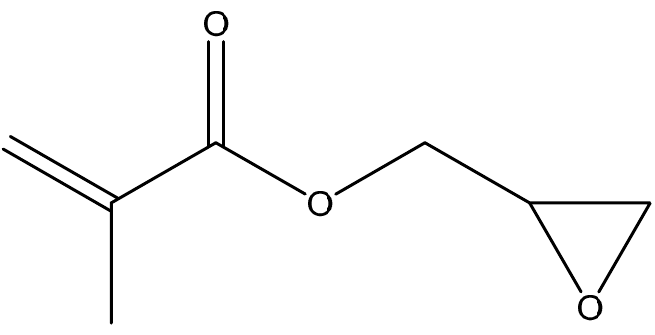
Figure 16. Chemical structure of glycidyl methacrylate.